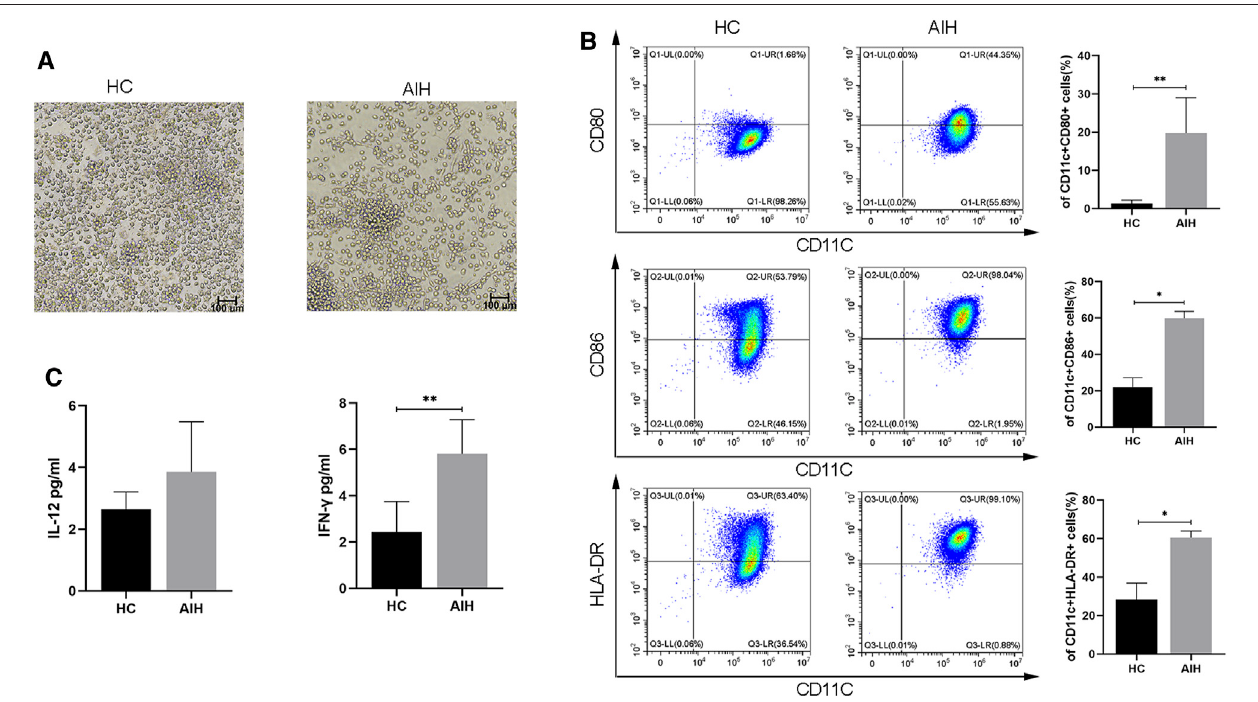
FIGURE 2 | Differences in the phenotype and cytokines of moDCs from HCs and AIH patients after LPS stimulation. (A) Morphology of mature moDCs; magni fi cation, 200 × . (B) Flow cytometry wasused todetect theexpression ofCD80, CD86 and HLA-DR between HCs and AIH patients. (C) The levels ofthe cytokines IL-12 and IFN- γ in the supernatant of cell cultures. * p < 0.05 and ** p <